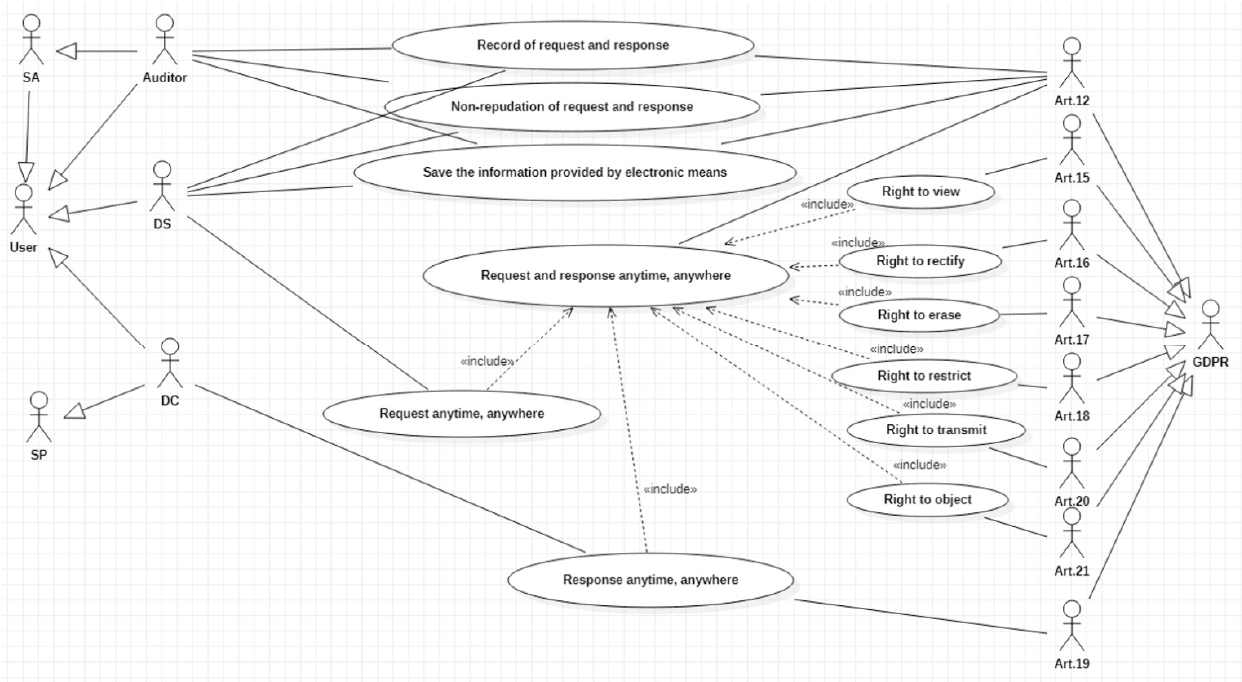
Figure 4. Requirements to support GDPR compliance audits regarding the DS’s requests.